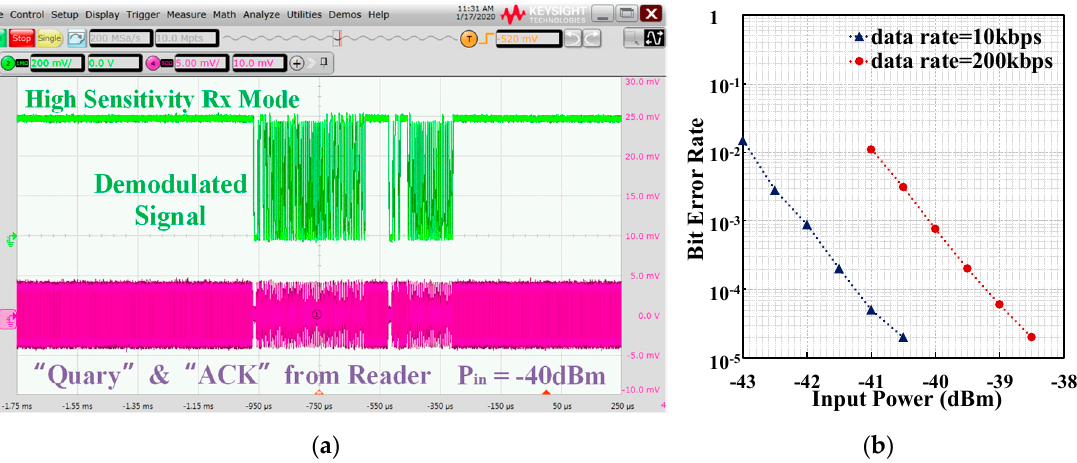
Figure 19. ( a ) Measured input signal and demodulated signal in HS mode; ( b ) bit error rate (BER) in